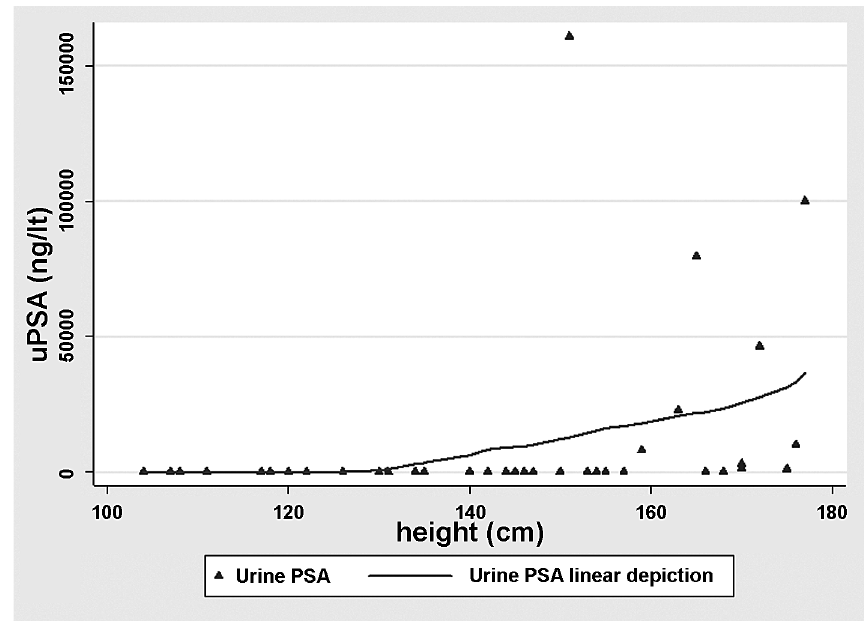
Figure 2 – Urine PSA in boys in relation to height. The slope is proportional to that of Figure-1 reflecting as a major contributor of increase entry of boys into